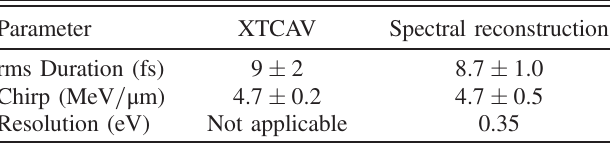
TABLE IV. Comparison of measurements from the XTCAV with our reconstruction for the smaller chirp case. The SASE bandwidth was estimated in the text as 4.1 eV. The uncertainties in the reconstructed values reflect a (cid:3) 0 . 5 eV assumed uncertainty in the SASE